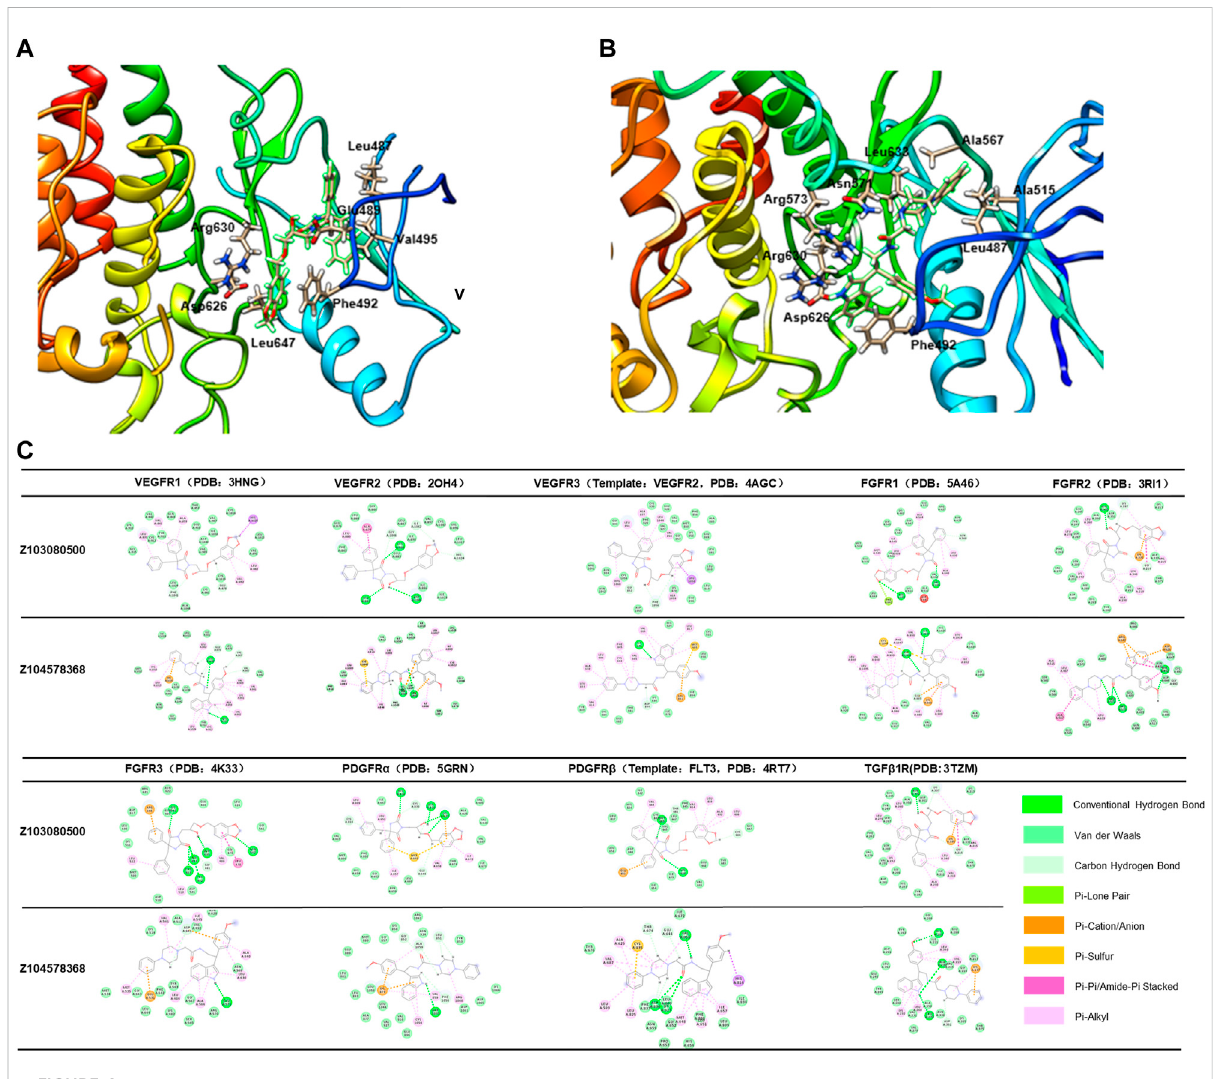
FIGURE 4 Binding of compounds Z03080500 and Z104578368 to receptors. (A) Binding mode of Z103080500 with FGFR2. (B) Binding mode of Z104578368 with FGFR2. (C) Binding mode of ligands (Z103080500 and Z104578368) and their